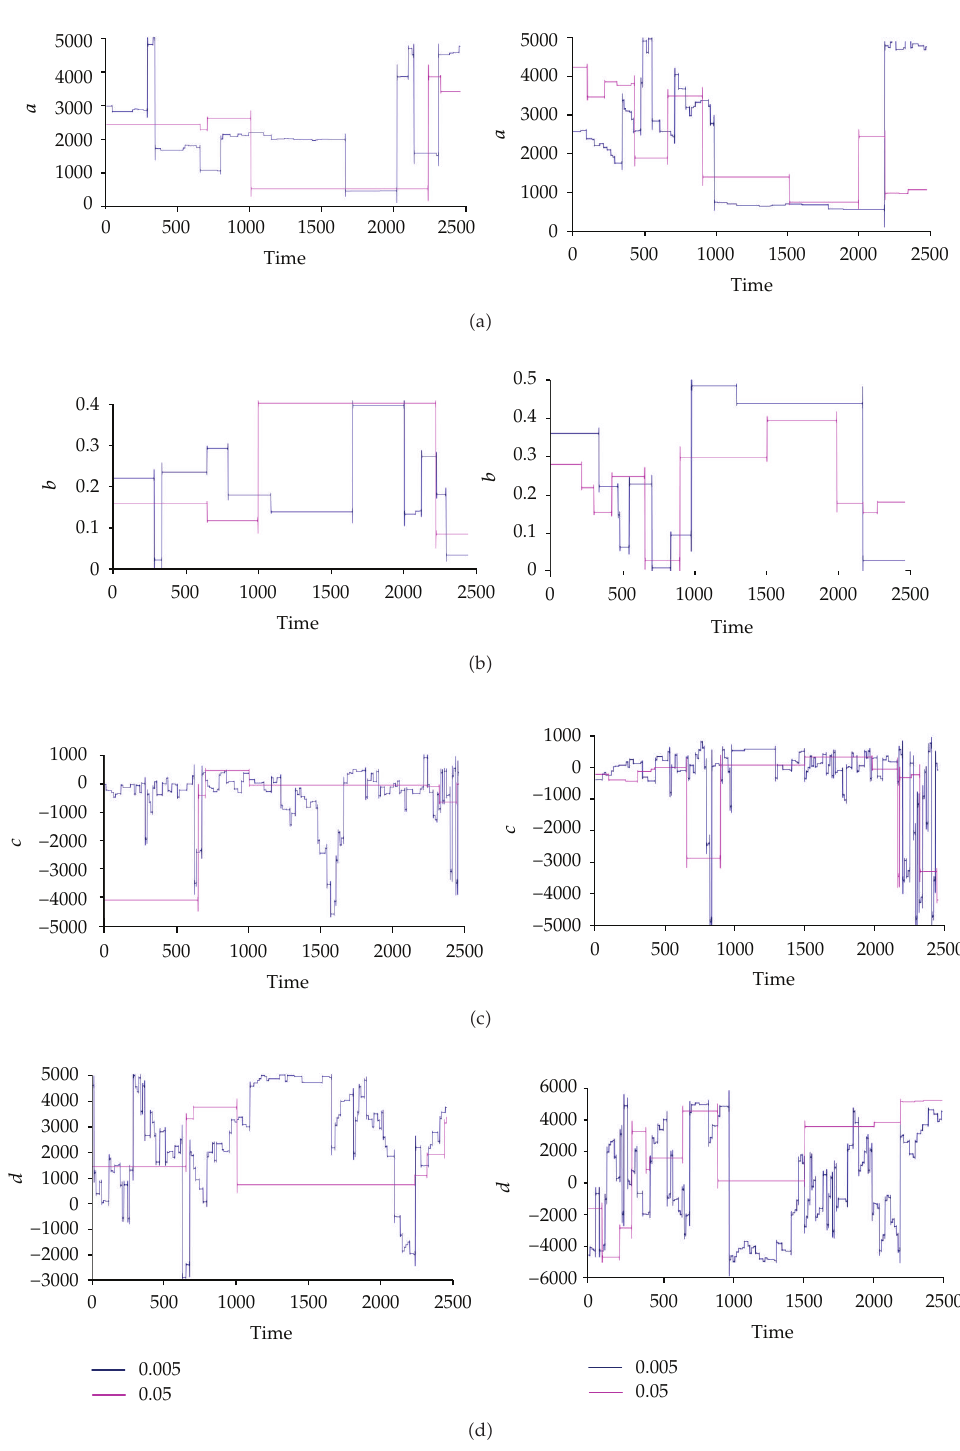
Figure 6: Values of the parameters { a,b,c,d } versus t , for the Dow Jones (cid:2) left (cid:3) and Nikkei (cid:2) right (cid:3) indices, with ε (cid:8) { 0 . 005 , 0 . 05 } from Jan. 2000 to Dec.